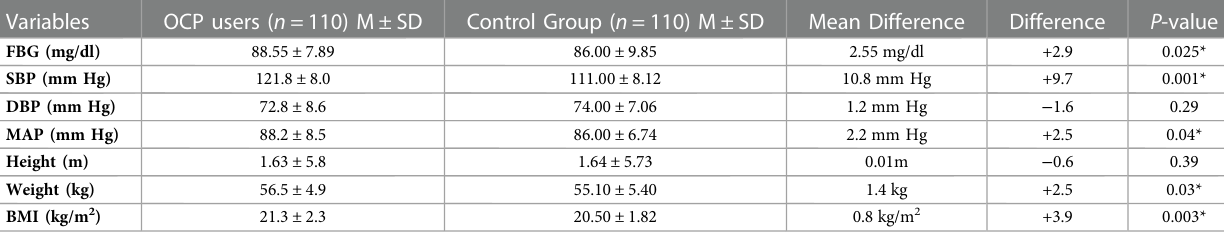
TABLE 2 The mean FBG level, MAP, height, weight, and BMI of study participants. Variables